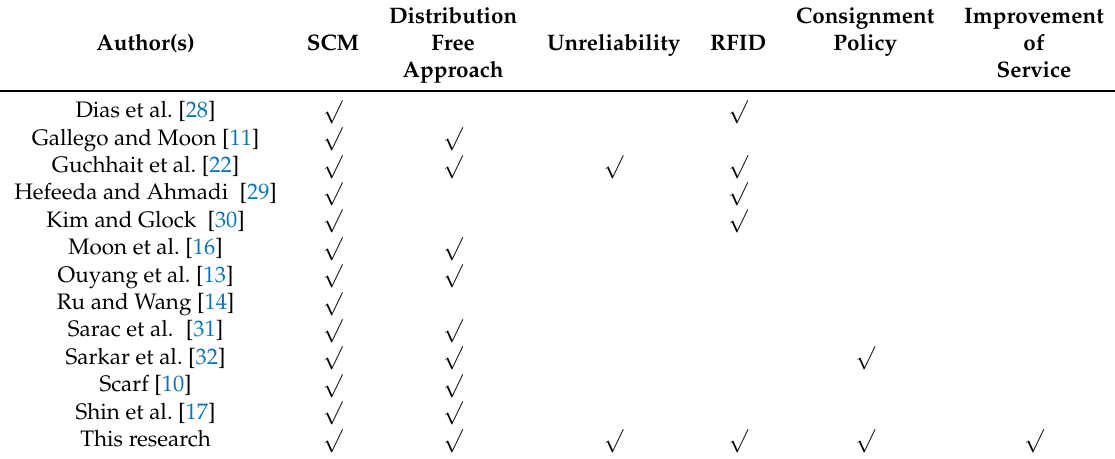
Table 1. Author contribution